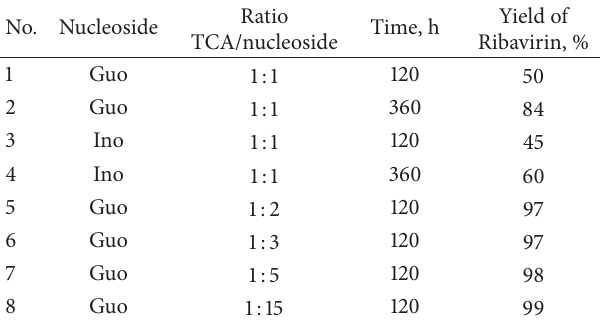
Table 1: Optimization of transglycosylation condition. Table 2: The Ribavirin synthesis with different biocatalytical sys-